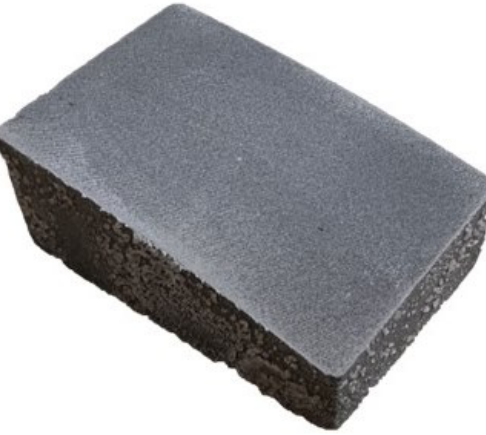
Figure 8. Machined BJAM SiC sample.